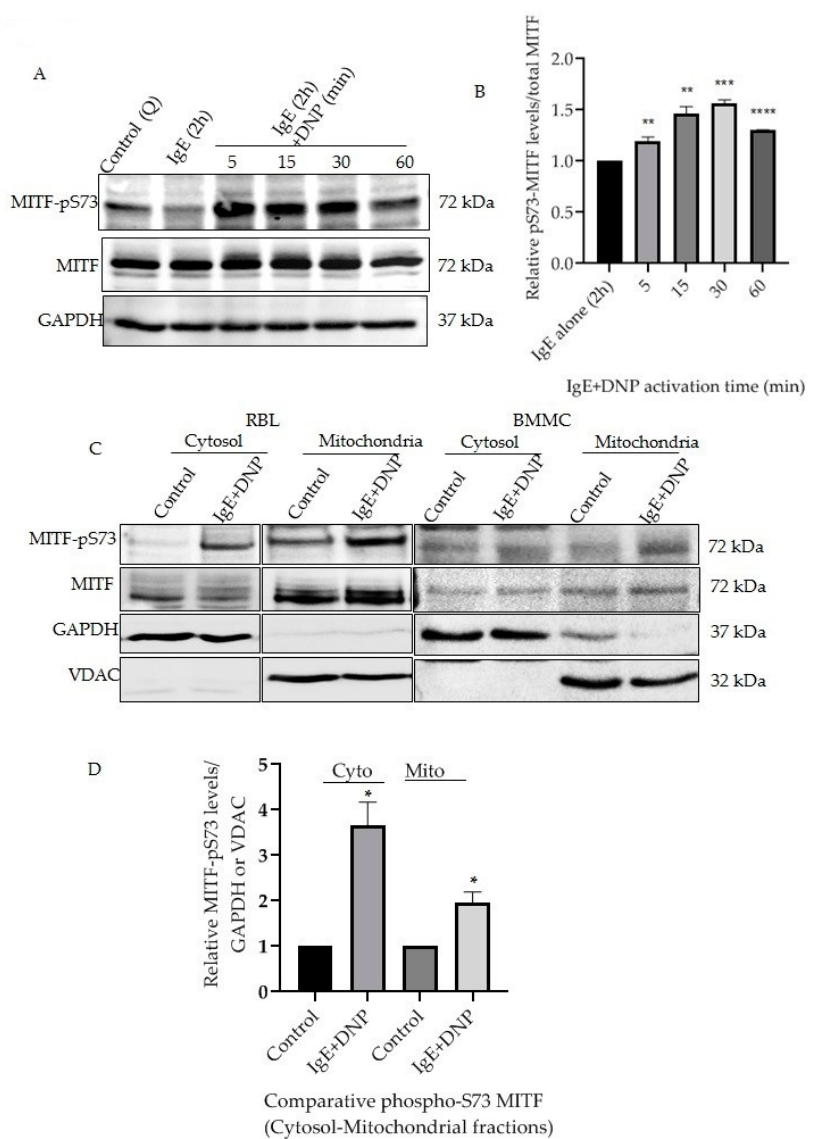
Figure 1. IgE-Ag stimulation affects mitochondrial MITF Serine 73 phosphorylation. ( A ), RBL cells were sensitized with 100 ng/mL IgE for 2 h followed by a 0–60 min DNP challenge. Non-sensitized cells are presented as Control (Q: Quiescent). The protein levels of MITF in the whole cell lysates were determined by Western blot analysis using anti-pS73-MITF, anti-MITF and anti-GAPDH antibodies. ( B ), Densitometry of MITF-pS73/MITF levels in RBL cells that were activated for 0–60 min. ( C ), RBL and BMMCs were treated with 100 ng/mL IgE for 2 h followed by a 15 min DNP challenge and were fractionated into cytosol and mitochondria. The protein levels of MITF in both fractions were determined by Western blot analysis using anti-pS73-MITF, anti-MITF, anti-GAPDH (cytosolic marker) and anti-VDAC (mitochondrial marker) antibodies. ( D ), Densitometry of MITF-pS73/GAPDH and MITF-pS73/VDAC levels in RBL cells that were activated for 15 min followed by cytosolic and mitochondrial fractionation. A two-tailed Student t -test was performed for all the western blots. Results represent means ± SEMs (n = 4, **** p ≤ 0.0001; *** p ≤ 0.001; ** p ≤ 0.01; * p ≤ 0.05; ns p > 0.05).